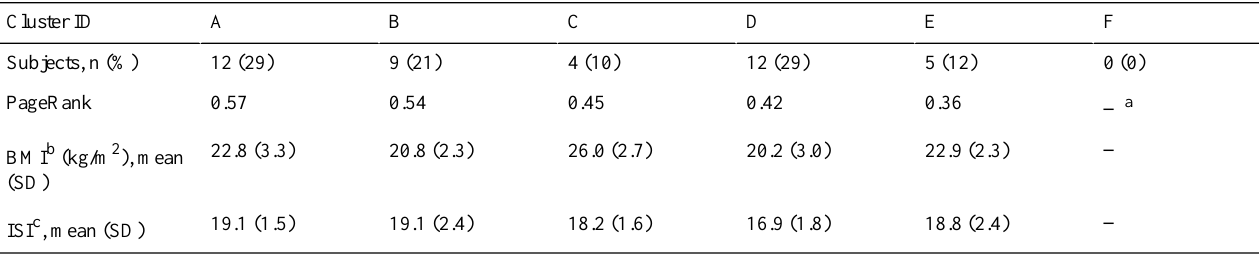
Table 2. Diachronic clustering results of 42 participants suffering from insomnia.